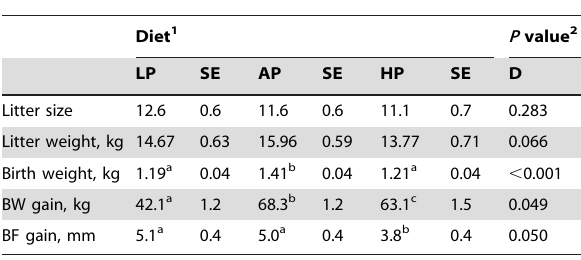
Table 1. Litter size and litter weight at birth, individual birth weight of progeny, and cumulative body weight (BW) and back fat (BF) gain from insemination until 109 dpc of sows fed isoenergetic diets with low protein:high carbohydrate (6.5% crude protein, LP), adequate protein:carbohydrate (12.1% crude protein, AP), and high protein:low carbohydrate (30% crude protein, HP) ratios throughout pregnancy (EXP1) (modified after